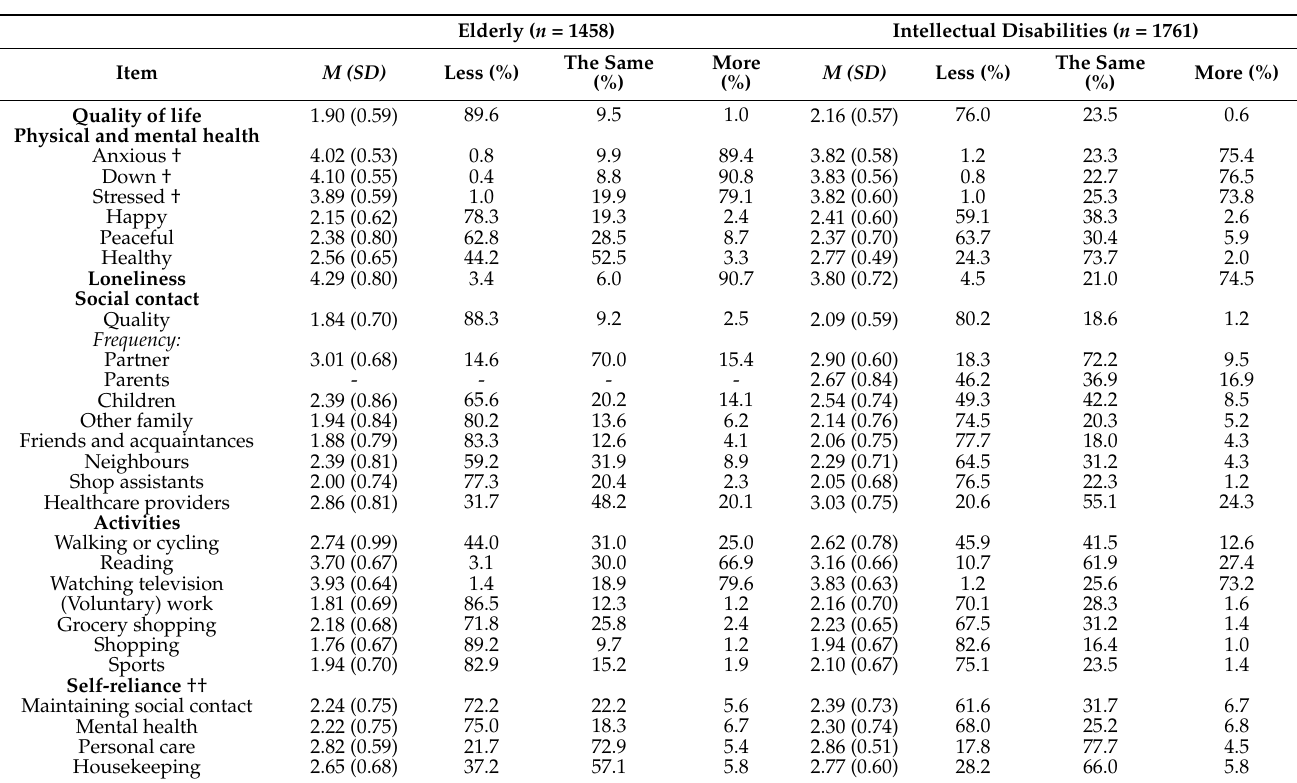
Table 2. Descriptives of the perceived impact of COVID-19 on the elderly and individuals with intellectual disabilities. Elderly ( n = 1458) Intellectual Disabilities ( n =